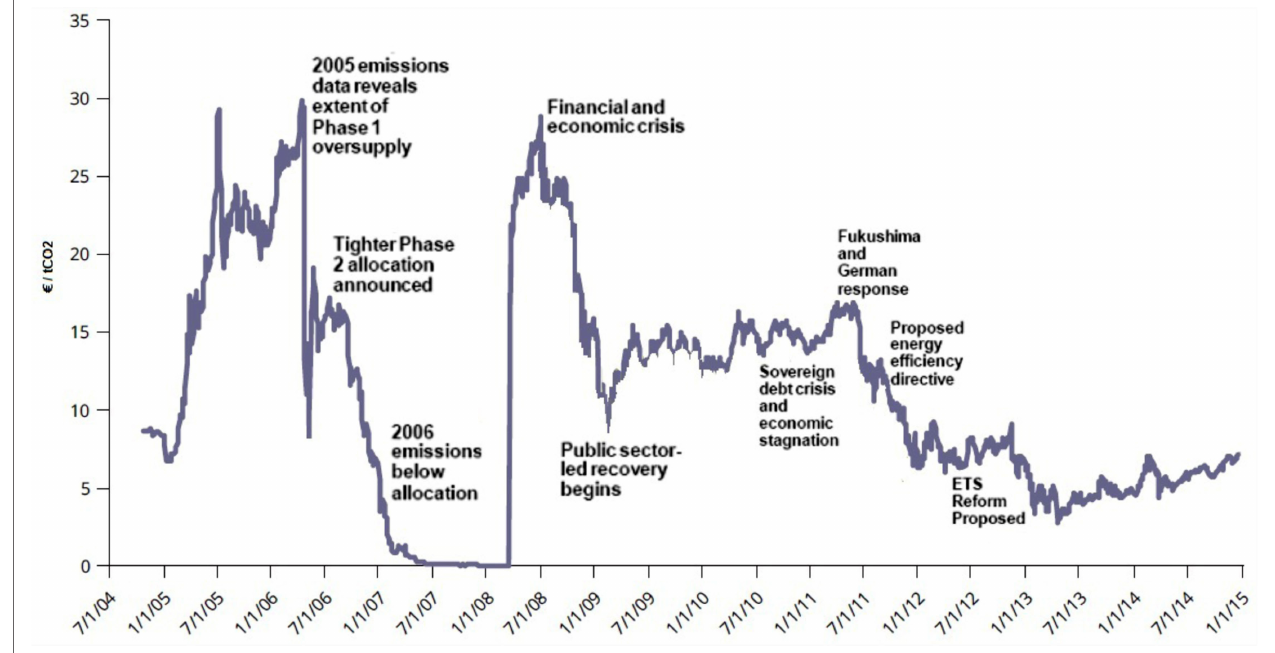
FiGURe 1 | intertemporal evolution of eUA prices and major events in the period 2005–2015 . Source: authors’ own elaboration based on EEA